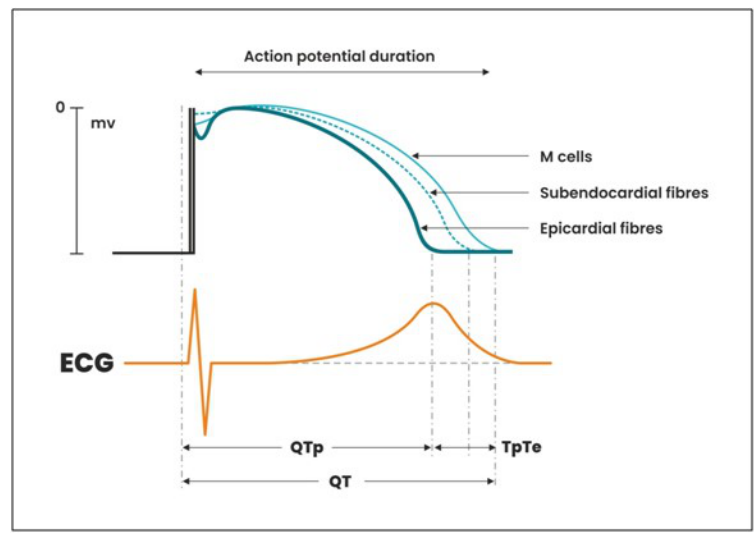
Figure 1. Formation of total QT repolarization time, QTp (Q-Tpeak) and TpTe